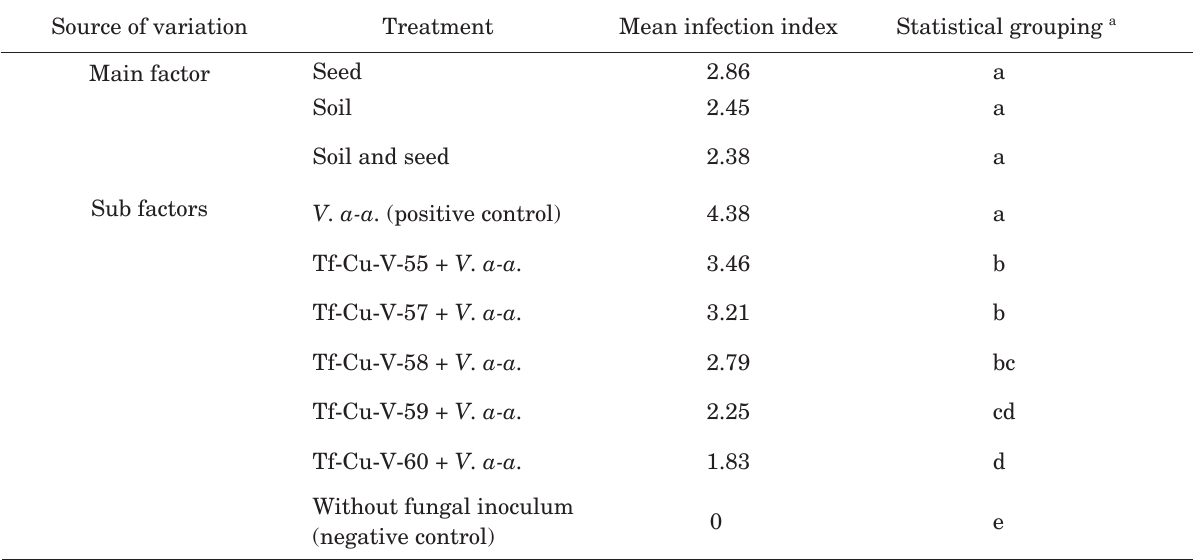
Table 2. The effects of the main factor (different Talaromyces flavus treatments) and subfactors (different T. flavus isolates) on the Verticillium wilt infection index in greenhouse cucumber